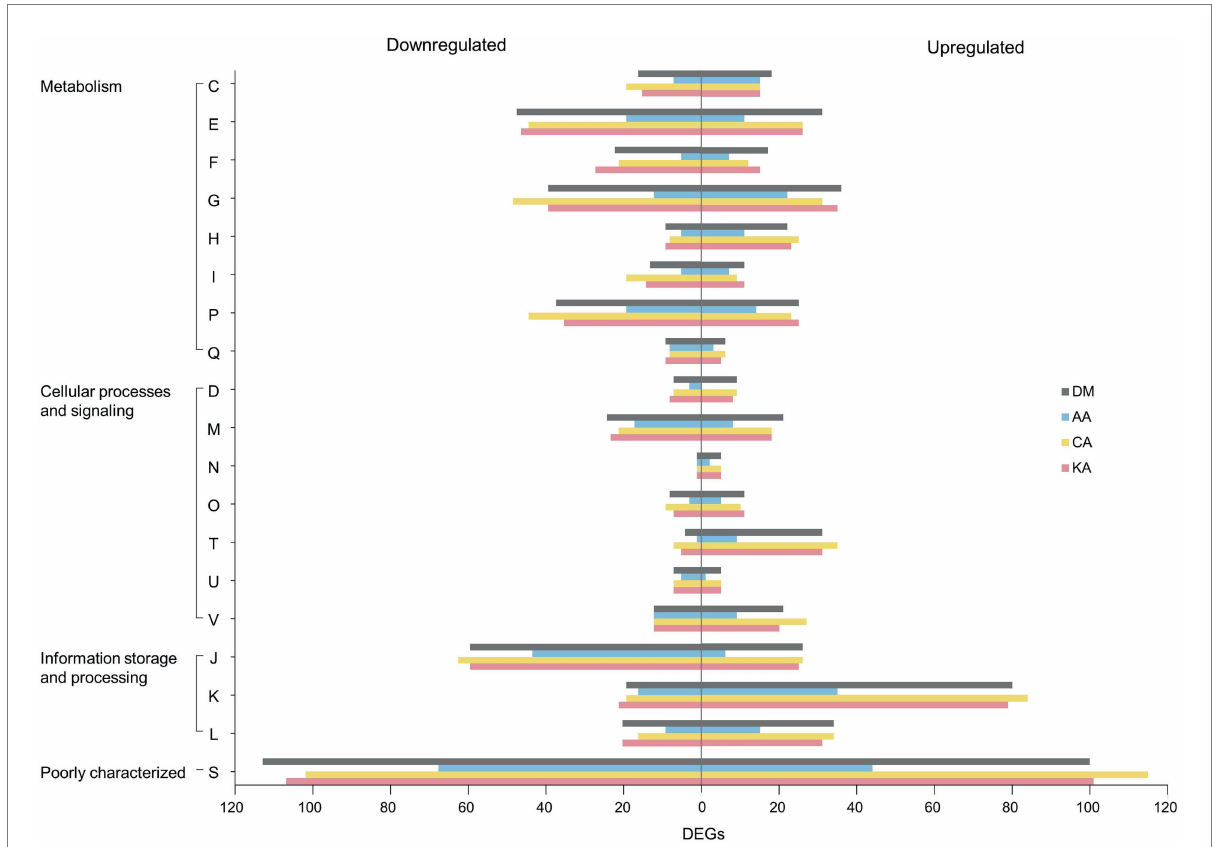
FIGURE 5 Cluster of Orthologous Groups (COG) classification of the identified DEGs. The alphabetical codes represent the following functional categories: C, energy production and conversion; E, amino acid transport and metabolism; F, nucleotide transport and metabolism; G, carbohydrate transport and metabolism; H, coenzyme metabolism; I, lipid metabolism; P, inorganic ion transport and metabolism; Q, secondary metabolite biosynthesis, transport, and catabolism; D, cell division and chromosome partitioning; M, cell envelope biogenesis and outer membrane; N, cell motility and secretion; O, post-translational modification, protein turnover, and chaperones; T, signal transduction mechanisms; U, intracellular trafficking, secretion, and vesicular transport; and V, defense mechanisms; J, translation, ribosomal structure, and biogenesis; K, transcription; L, DNA replication, recombination, and repair; S, function unknown (|log 2 | ≥ 1, p adj <